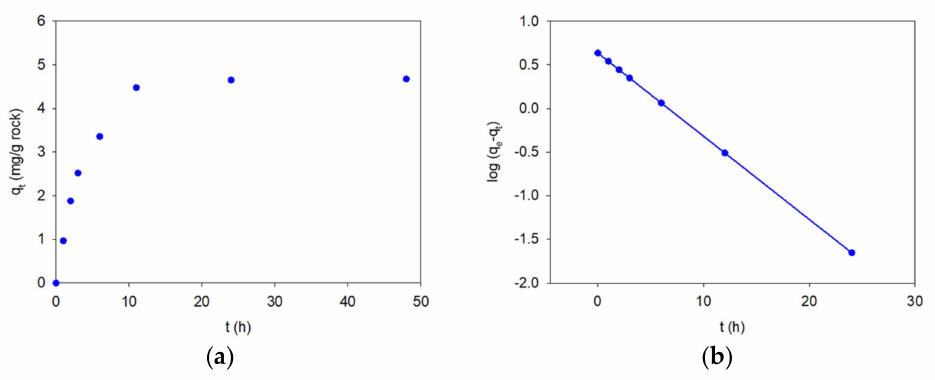
Figure 5. ( a ) Evolution of the surfactant adsorption with time. ( b ) Pseudo-first order fit (Equation